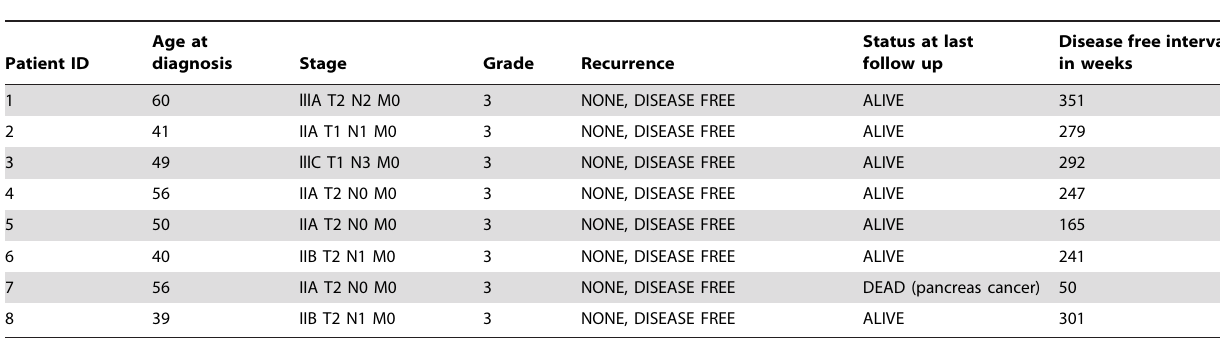
Table 3. Characteristics of NY-ESO-1 positive TNBC patients with NY-ESO-1 antibodies.